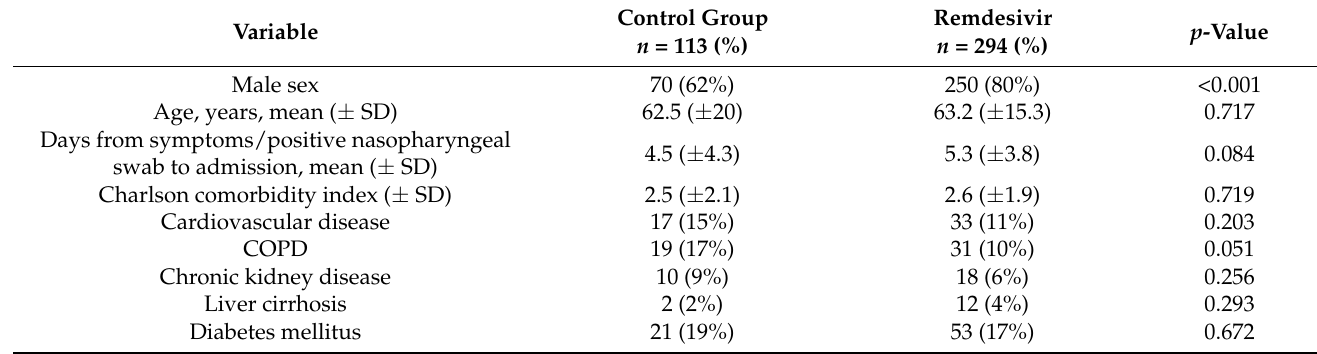
Table 1. Univariate analysis regarding demographics and clinical characteristics of COVID-19 patients treated with remdesivir or